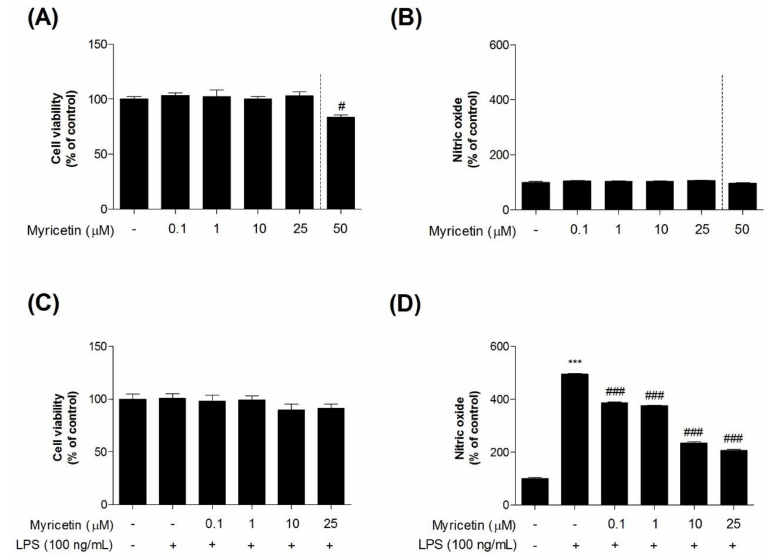
Figure 2. The e ff ect of myricetin on LPS-induced NO production in microglia BV2 cells. Cells were treated with myricetin for 1 h, and then stimulated with LPS for an additional 23 h. ( a , c ) The cell viability was assessed using an MTT assay. ( b , d ) The culture supernatant was also subjected to nitrite quantification. Values are means ± standard error of the mean. *** p < 0.001 compared to the control group, and # p < 0.05 and ### p < 0.001 compared to the LPS-alone group. LPS, lipopolysaccharide; NO, nitric